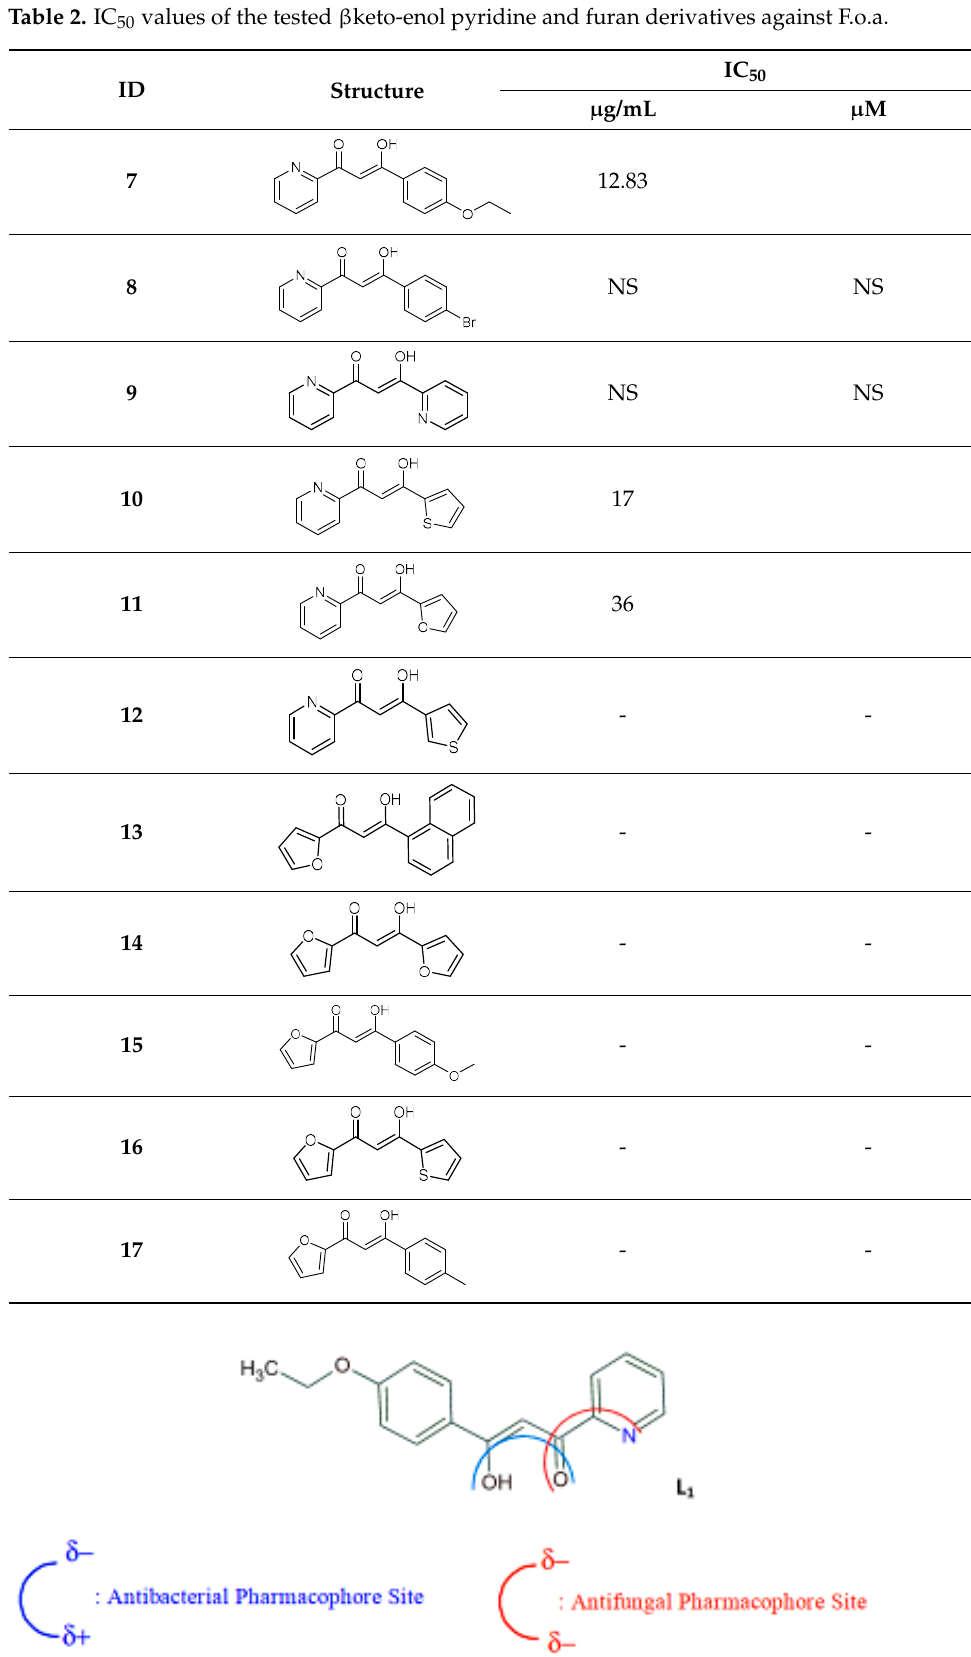
Figure 1. Antibacterial and antifungal pharmacophore sites for compound 7 .